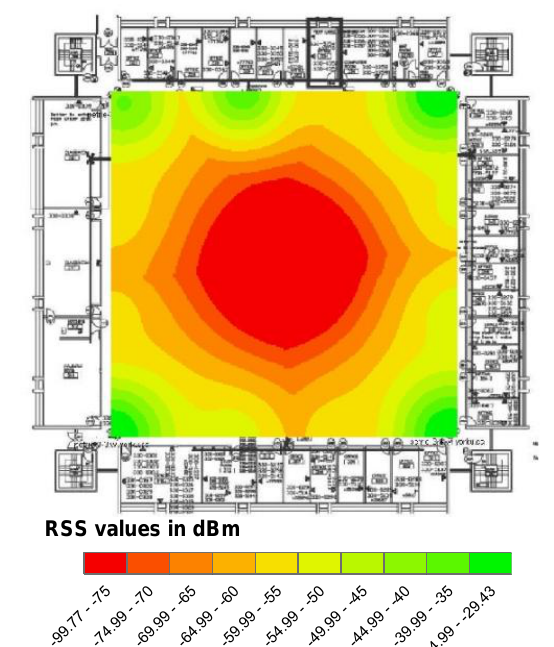
Figure 3 – Received Signal Strength (RSS) radio map for